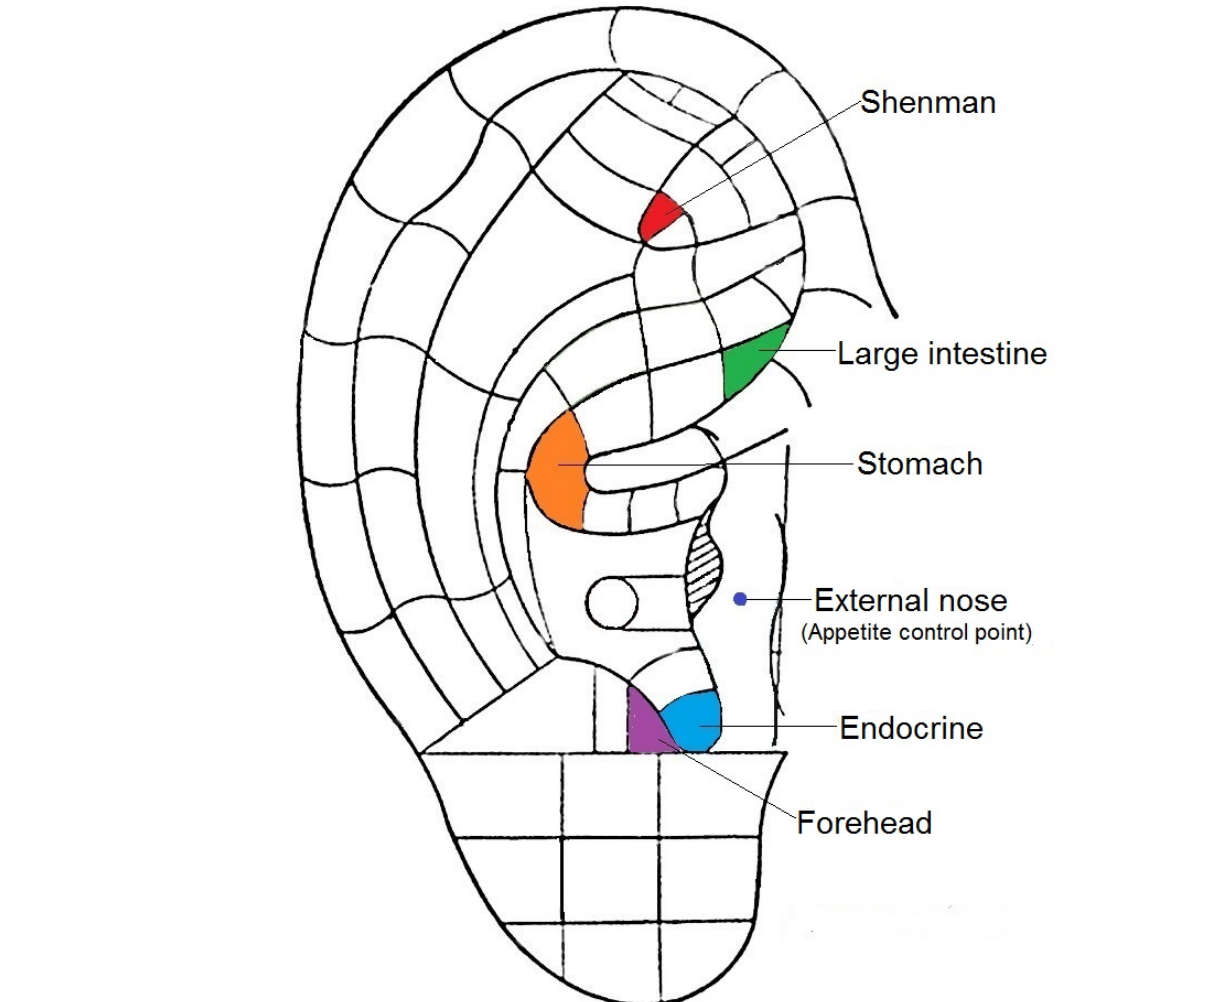
Figure 1. Ear acupoints for weight